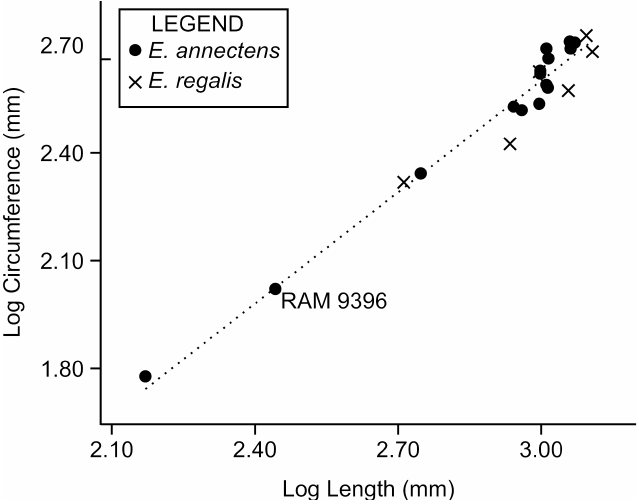
Figure 5. Linear regression (RMA) showing femur length versus femur circumference for Edmontosaurus spp. Data presented in Table